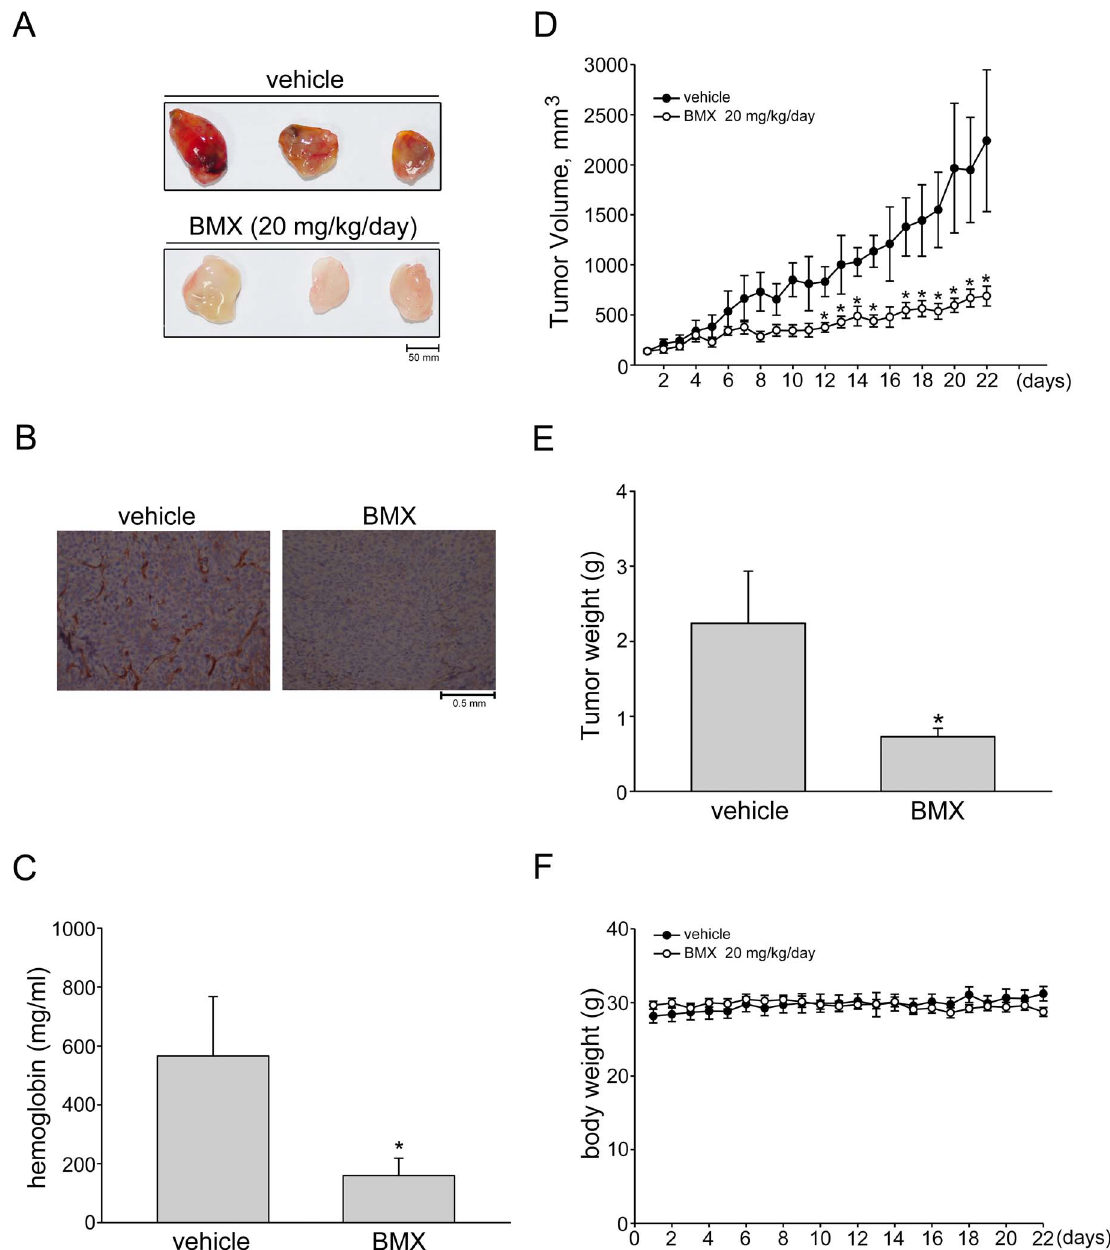
Figure 6. BMX inhibited tumor-induced neovascularization and suppressed invivo tumor growth in nude mice. (A) HCT 116 colorectal cancer cells were mixed with Matrigel and then injected subcutaneously into the right flank of nude mice. After implantation, animals were treated intraperitoneally with vehicle or BMX 20 mg/kg/day for 10 days. Matrigel plugs removed from the mice administered intraperitoneally with vehicle or BMX were shown. (B) The blood vessels in the Matrigel plug were stained with anti-CD31 antibody as described in the ‘‘ Materials and Methods ’’ section. Images of immunohistochemical staining representative of three independent Matrigel plug with similar results are shown. (C) Hemoglobin levels in the Matrigel plug shown in (A) were quantified. Each column represents the mean 6 S.E.M. of six plugs in each group ( * p , 0.05 as compared with the vehicle-treated control group, n=5). (C) Nude mice bearing xenografts of HCT116 colorectal cancer cells were treated intraperitoneally with BMX 20 mg/kg/day for 22 days. The control group received vehicle only. Tumor volumes were calculated as described in the Materials and Methods section. Values represents the mean 6 S.E.M. ( * p , 0.05 as compared with the vehicle-treated control group, n=5). (D) After 22 days of treatment as in (C), mice were sacrificed and tumors were dissected and weighted. Each column represents the mean 6 S.E.M. ( * p , 0.05 as compared with the vehicle-treated control group, n=5). (E) The body weights of the nude mice were examined within 22 days treatment of vehicle or BMX. Values represent the mean 6 S.E.M. doi:10.1371/journal.pone.0081592.g006 Y1214 phosphorylation of VEGFR2 in HUVECs exposed to plug assay also suggest that BMX attenuates HCT116 colorectal VEGF. BMX also inhibited VEGF-induced Src, Akt, ERK and cancer cells-induced angiogenesis. Taken together, we believe that FAK phosphorylation. Results demonstrated by in vivo Matrigel the inhibitory effects of BMX on VEGFR2 phosphorylation and